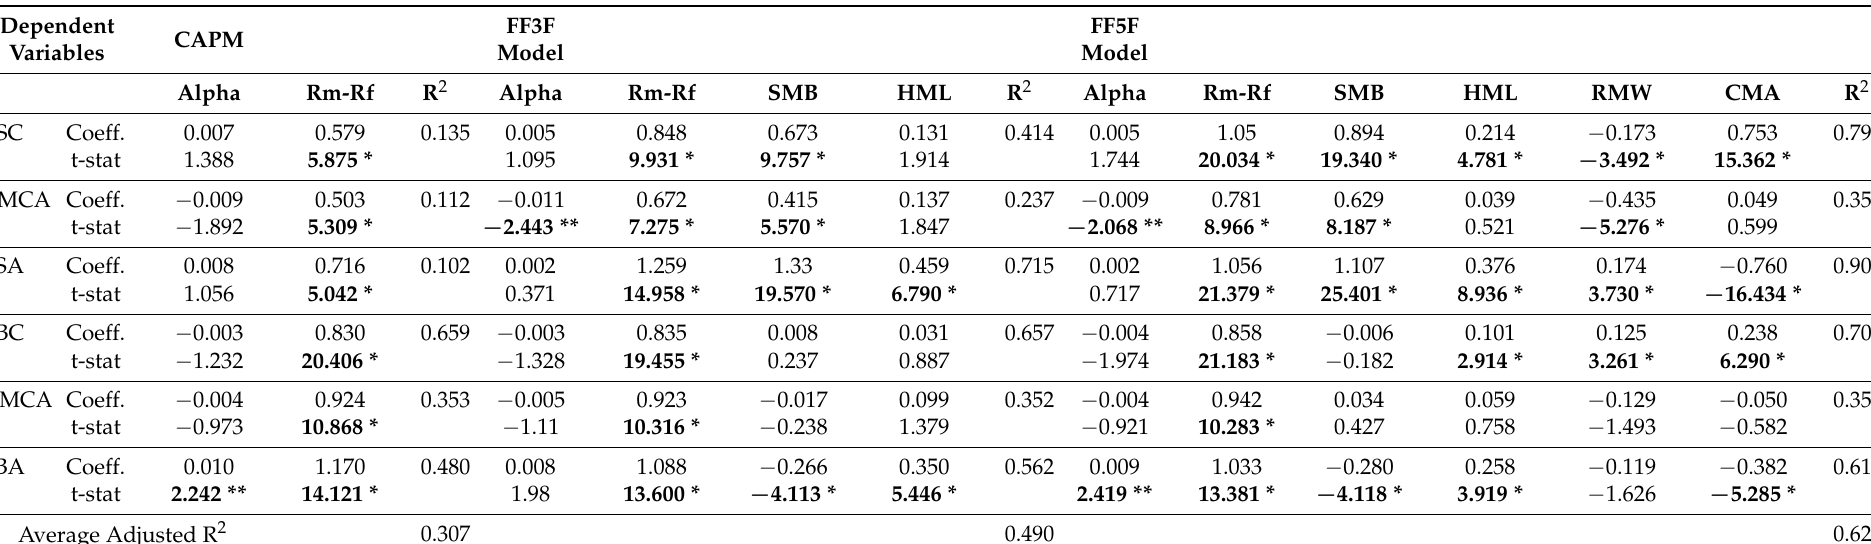
Table 8. Regression results of the CAPM, FF3F model and FF5F model for the 6 value-weighted size–Inv portfolios (July 2002–June